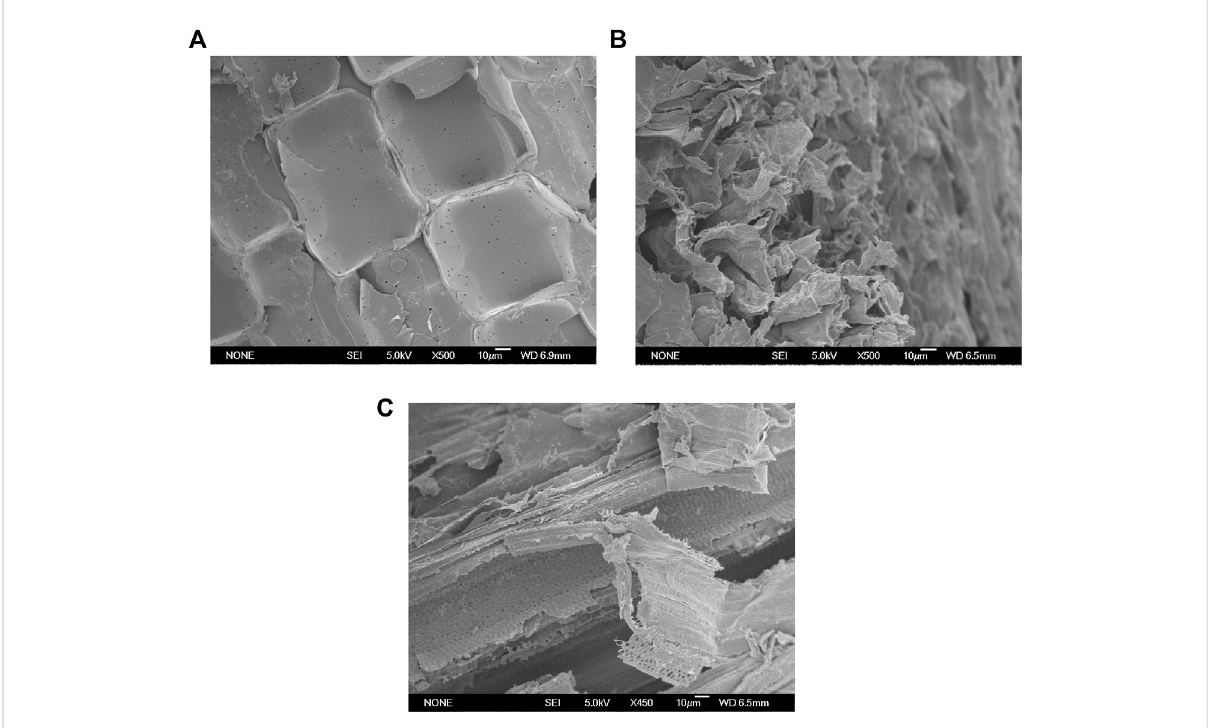
FIGURE 4 SEM observations of the stalk samples before and after pretreatments (500×). (A) Raw sample; (B) AP sample; (C) SAP